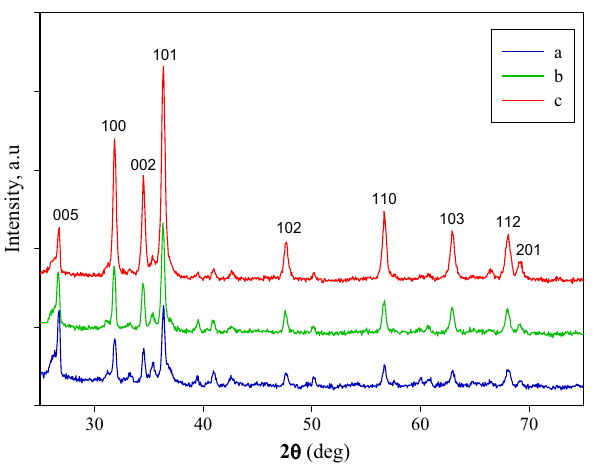
Fig. 1 XRD spectra of synthesized ZnO nanoparticles with different concentration of 0.01 (a), 0.02 (b) and 0.09 M (c) of zinc acetate